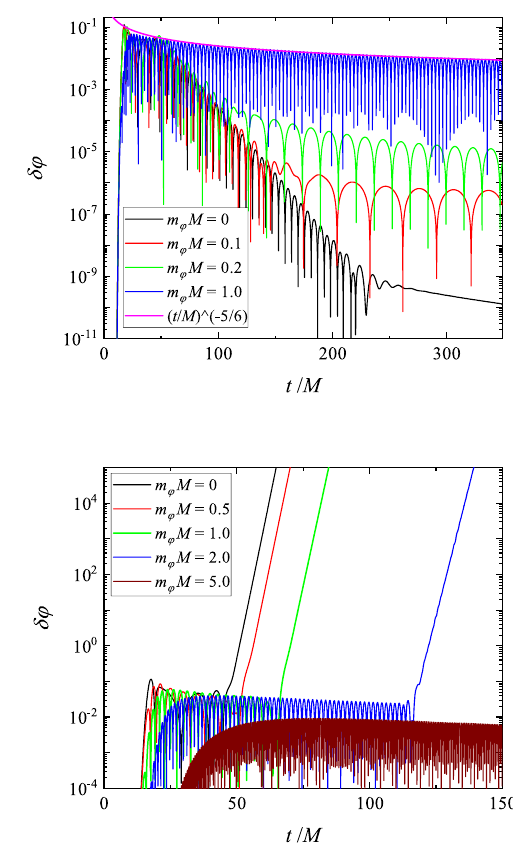
Fig. 1 The time evolution of δϕ for m = 0 and some representative stable(top)andunstable(bottom)blackholes.Inthestablecasewehave chosen a / M = 0 . 4, λ 2 / M 2 = 10 and several values of m ϕ , while for the unstable case we have chosen a / M = 0 . 8 and λ 2 / M 2 = 100. In the top panel, the expected analytical behavior of the late-time asymptotic of δϕ is plotted, i.e., δϕ ∼ ( t / M ) − 5 /